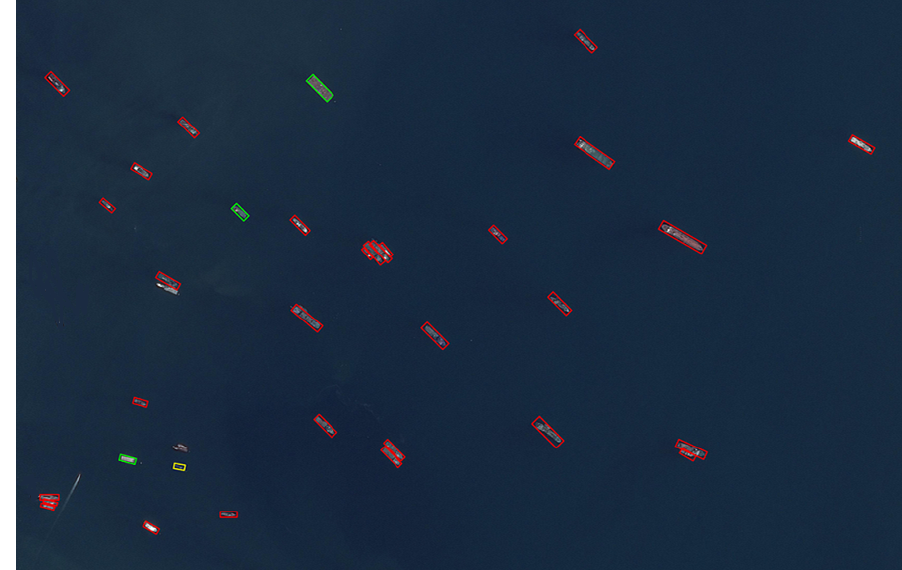
Figure 10. The detection results of one large-scale remote-sensing image (4356 × 2589). The red boxes denote the detection results from our method. The yellow boxes denote the missed ship objects. The green boxes indicate the wrong detections.